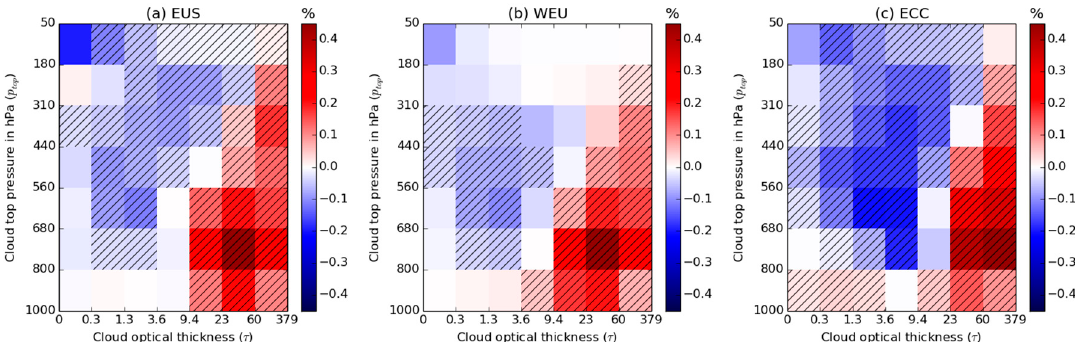
Figure 7. Regional (1st: EUS, 2nd: WEU, and 3rd: ECC) mean change in ISCCP-simulated cloud fraction in CTP (Cloud Top Pressure) - τ space for the T2 period (1980–2010) relative to the pre-industrial period (1850). The 90% significance denoted as dashed lines.